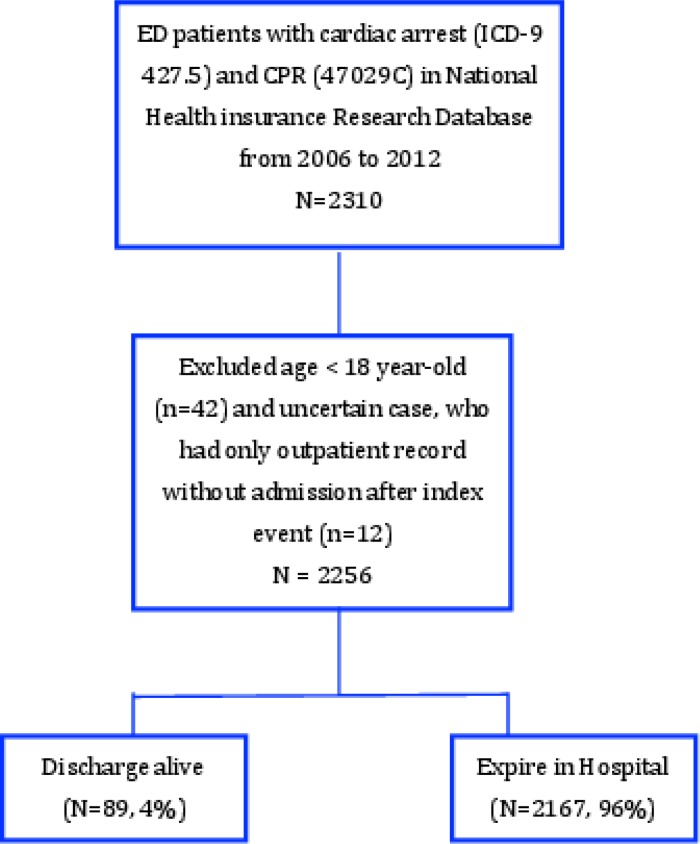
Patients enrolled.